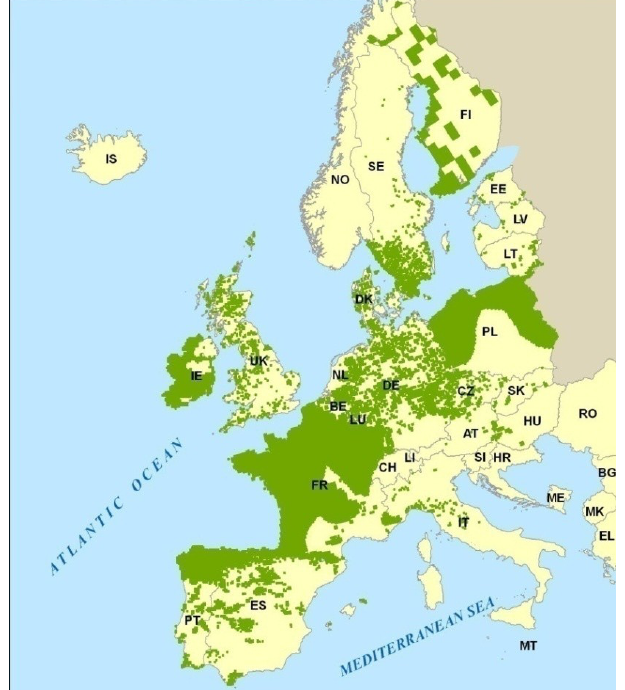
Figure 1. Distribution of the habitat type European dry heaths (Nat-2000 4030) in the European Union. Source: European Environment Agency